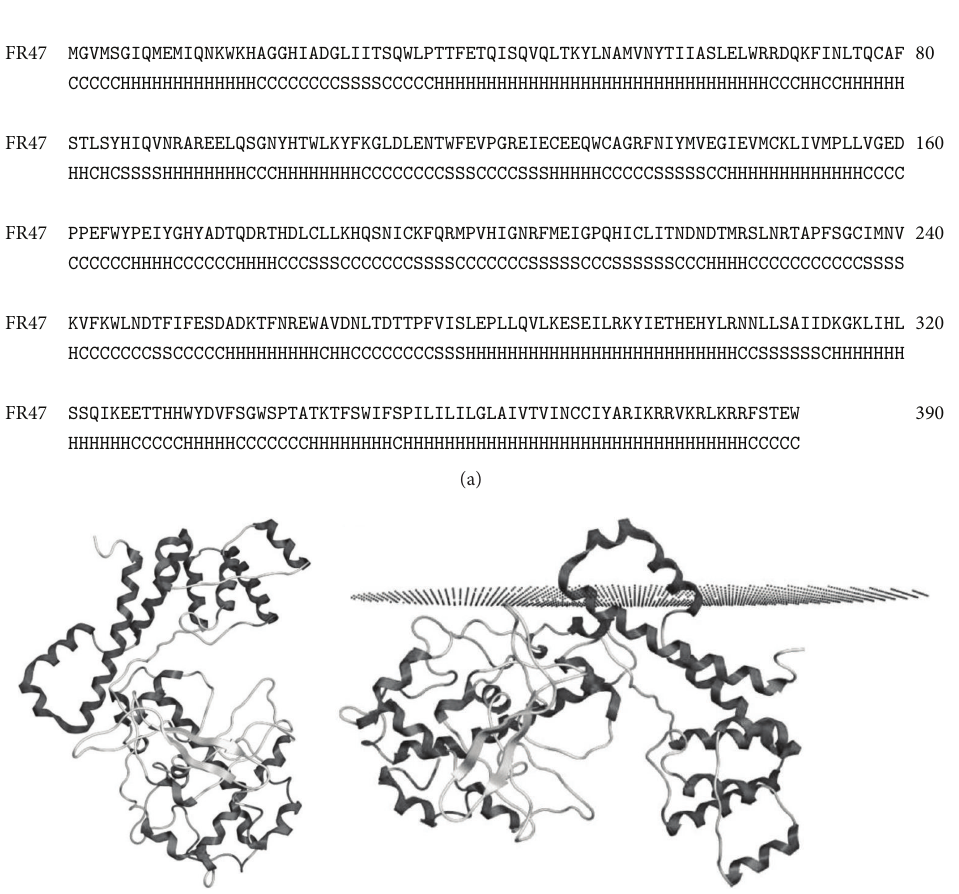
stages of tadpole development in the wood frog (Figure